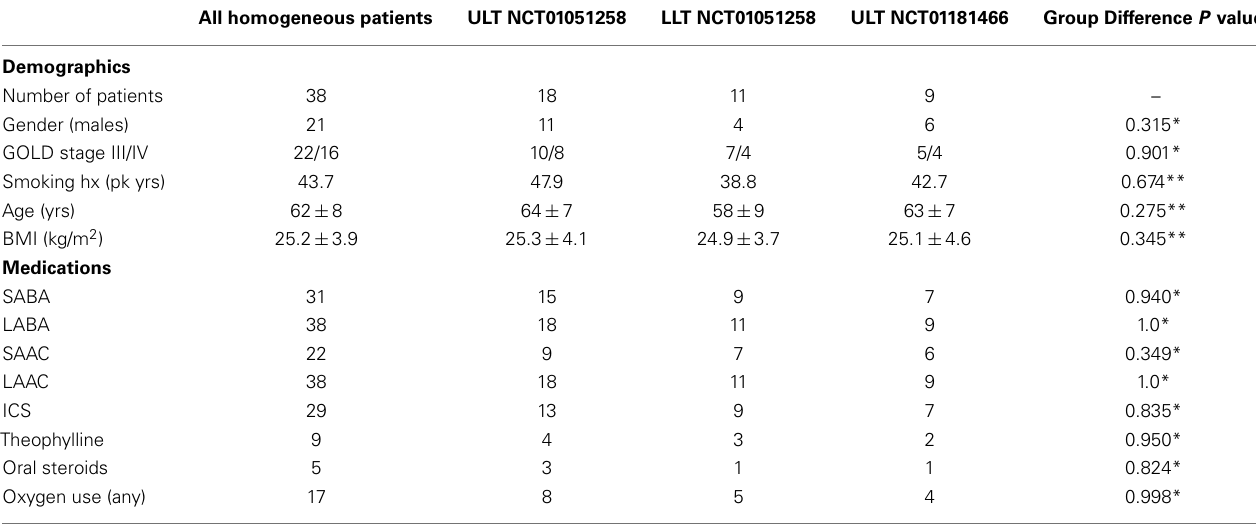
Table 1 | Summary of patient demographics and medical therapy.